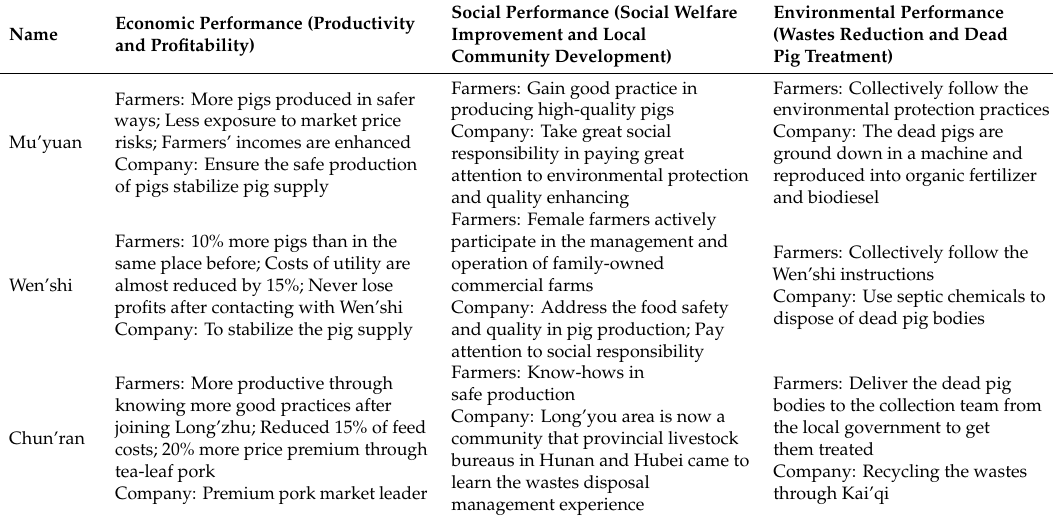
Table 4. Supply chain